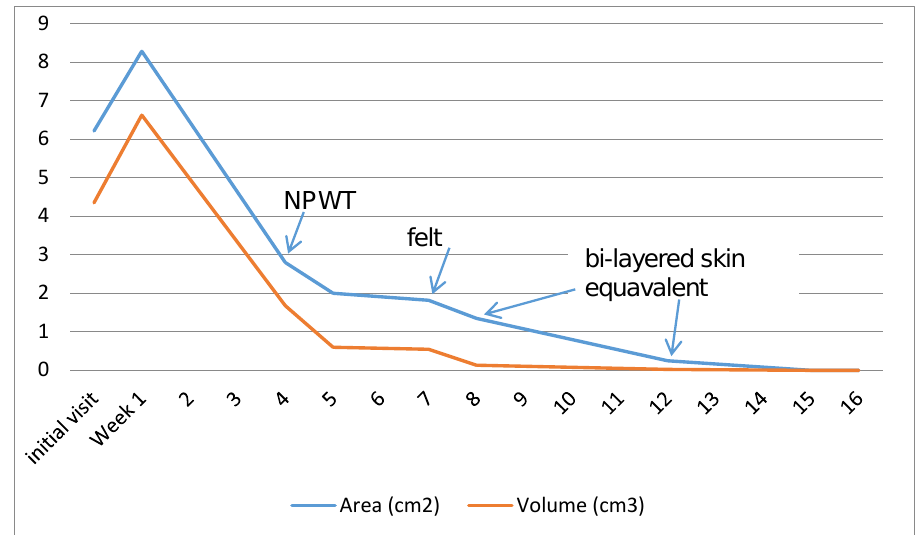
Figure 10. Area and wound measurements over time with NPWT, ¼ inch felt offloading, and bi-layered skin equivalent interventions indicated.